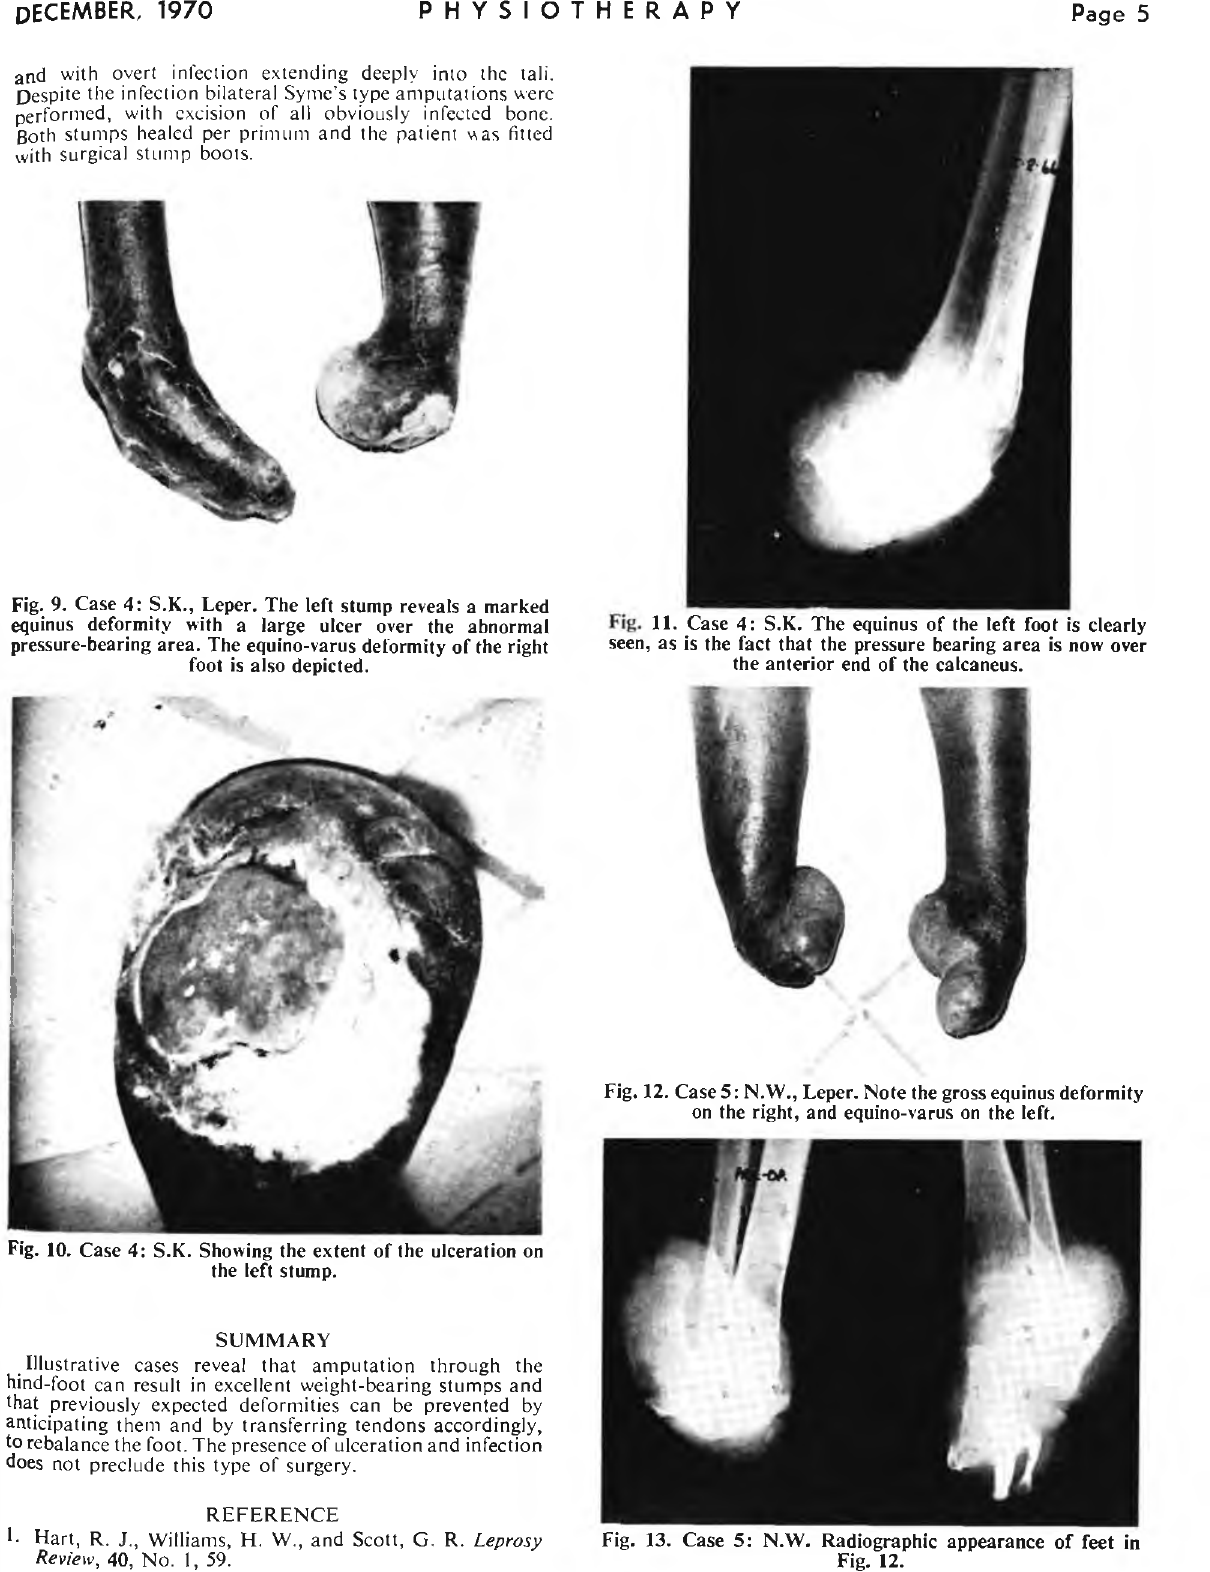
Fig. 13. Case 5: N.W. Radiographic appearance of feet in Fig.